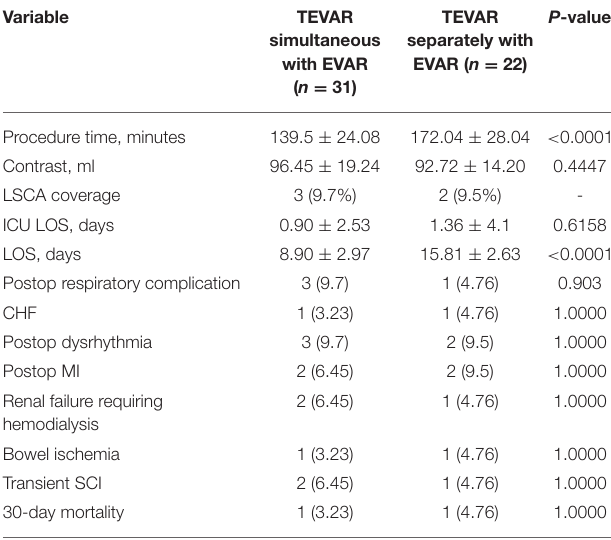
TABLE 2 | Operative and postoperative characteristic per surgical